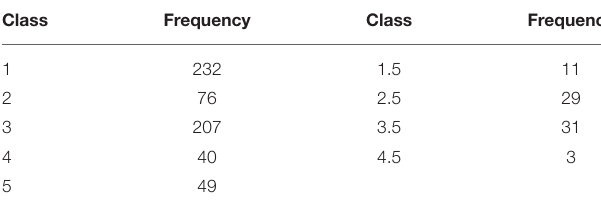
TABLE 4 | Distribution of verbatims between classes.